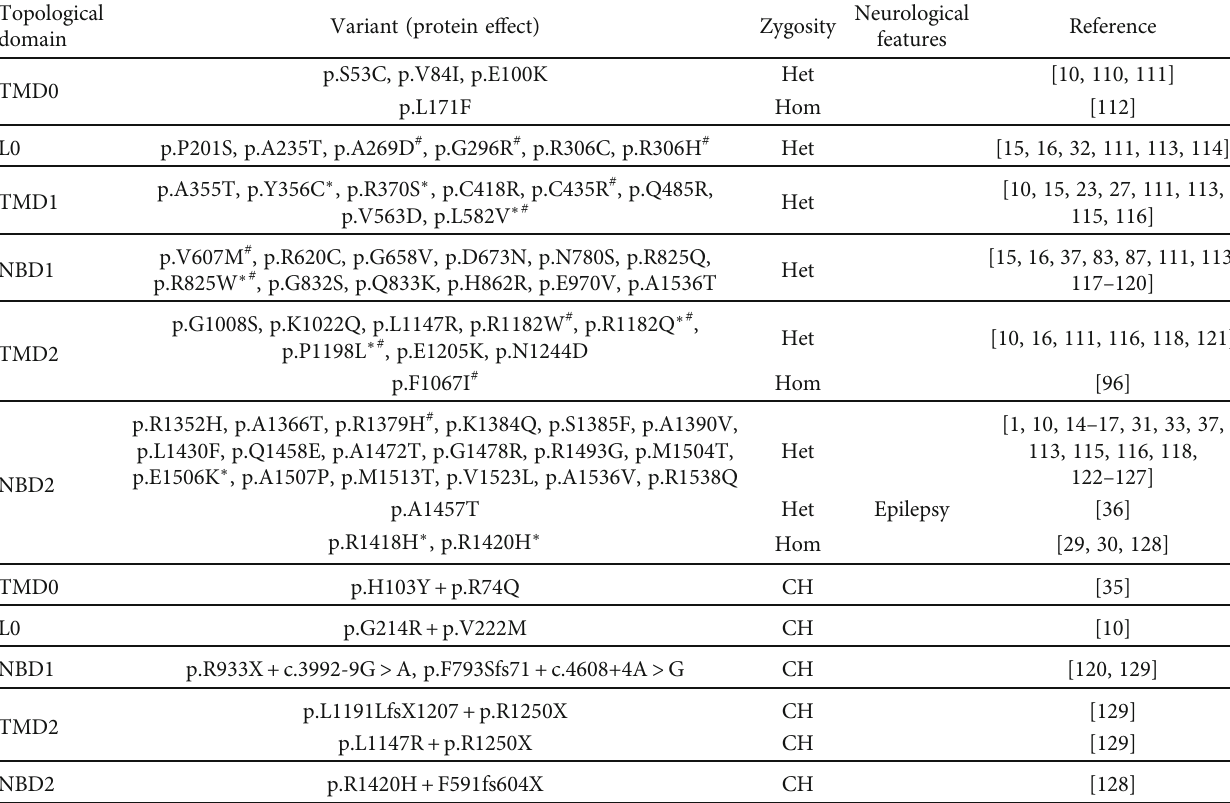
Table 2: Variants of ABCC8 causing ABCC8 -NNDM reported in previous studies.